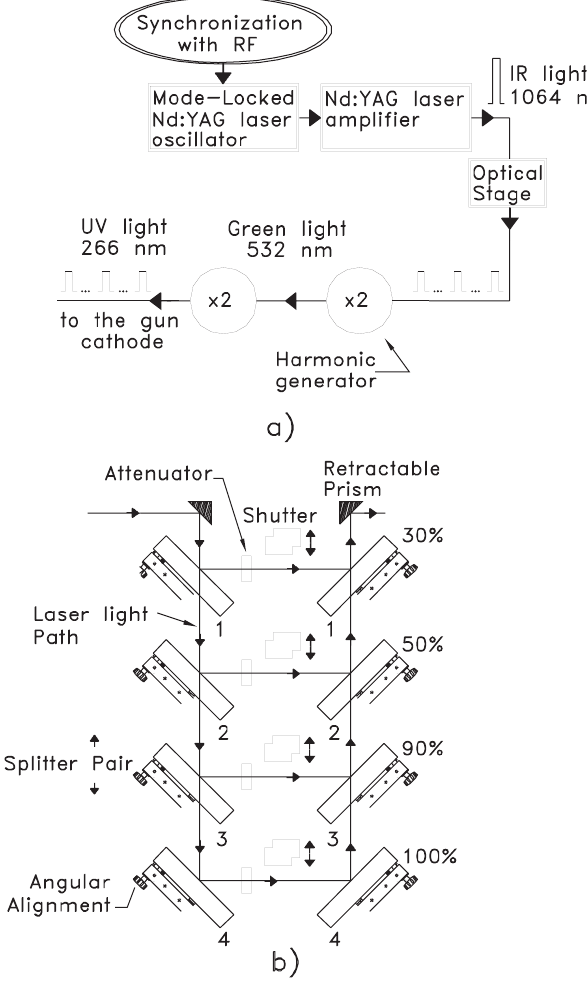
FIG. 3. (a) The ATF laser system schematic with the optical stage, and (b) the optical stage schematic. Percentages refer to the mirror